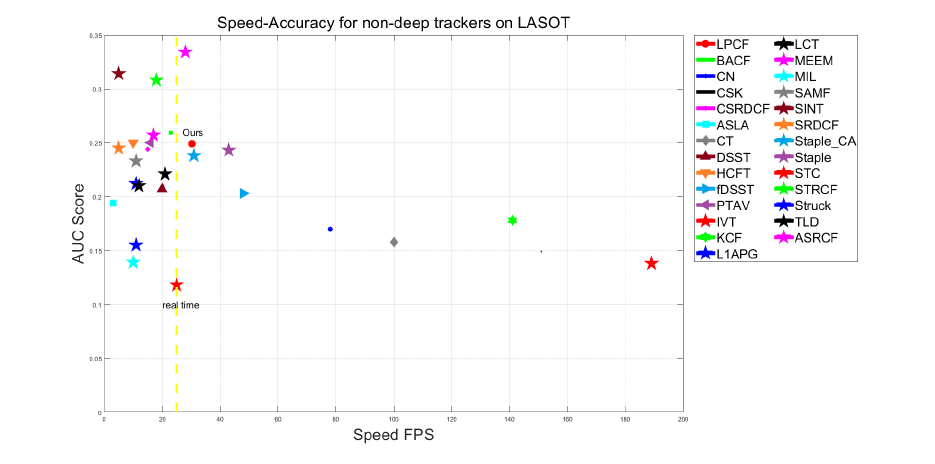
Figure 7. Comparison with 26 non-deep-learning trackers. Our proposed tracker LPCF (marked as red circle) achieves the second accuracy among all real-time (faster than 25 FPS) trackers.